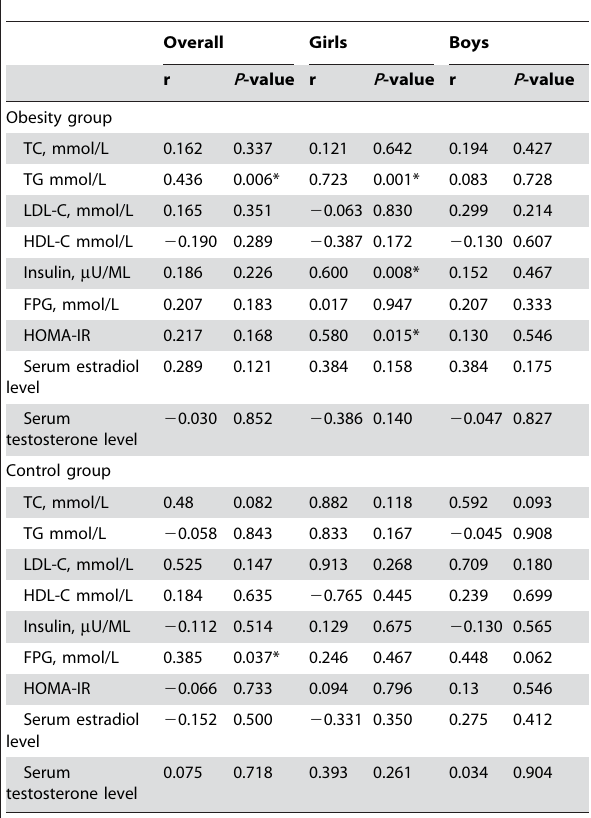
BMI, body mass index; FPG, fasting plasma glucose; HOMA-IR, homeostasis model assessment of insulin resistance; HDL-C, high density lipoprotein cholesterol; LDL-C, low density lipoprotein cholesterol; TC, total cholesterol; TG, triglycerides. Results are presented as coefficients of correlation (r) with respective P -value through partial correlation analysis after adjusting for age, sex, and BMI overall, and after adjusting for age and BMI in boys and girls separately. *indicates significant correlation. ( P ,